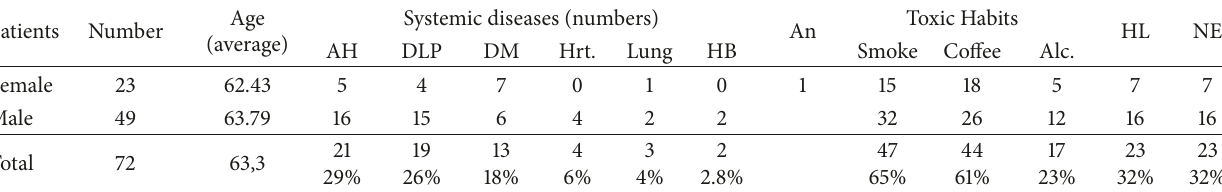
Table 1: Medical parameters of cancer patients undergoing cisplatin treatment ∗ .